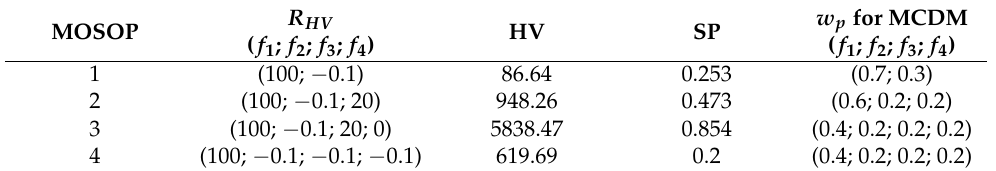
Table 2. Parameters used in the optimization results post-processing and performance